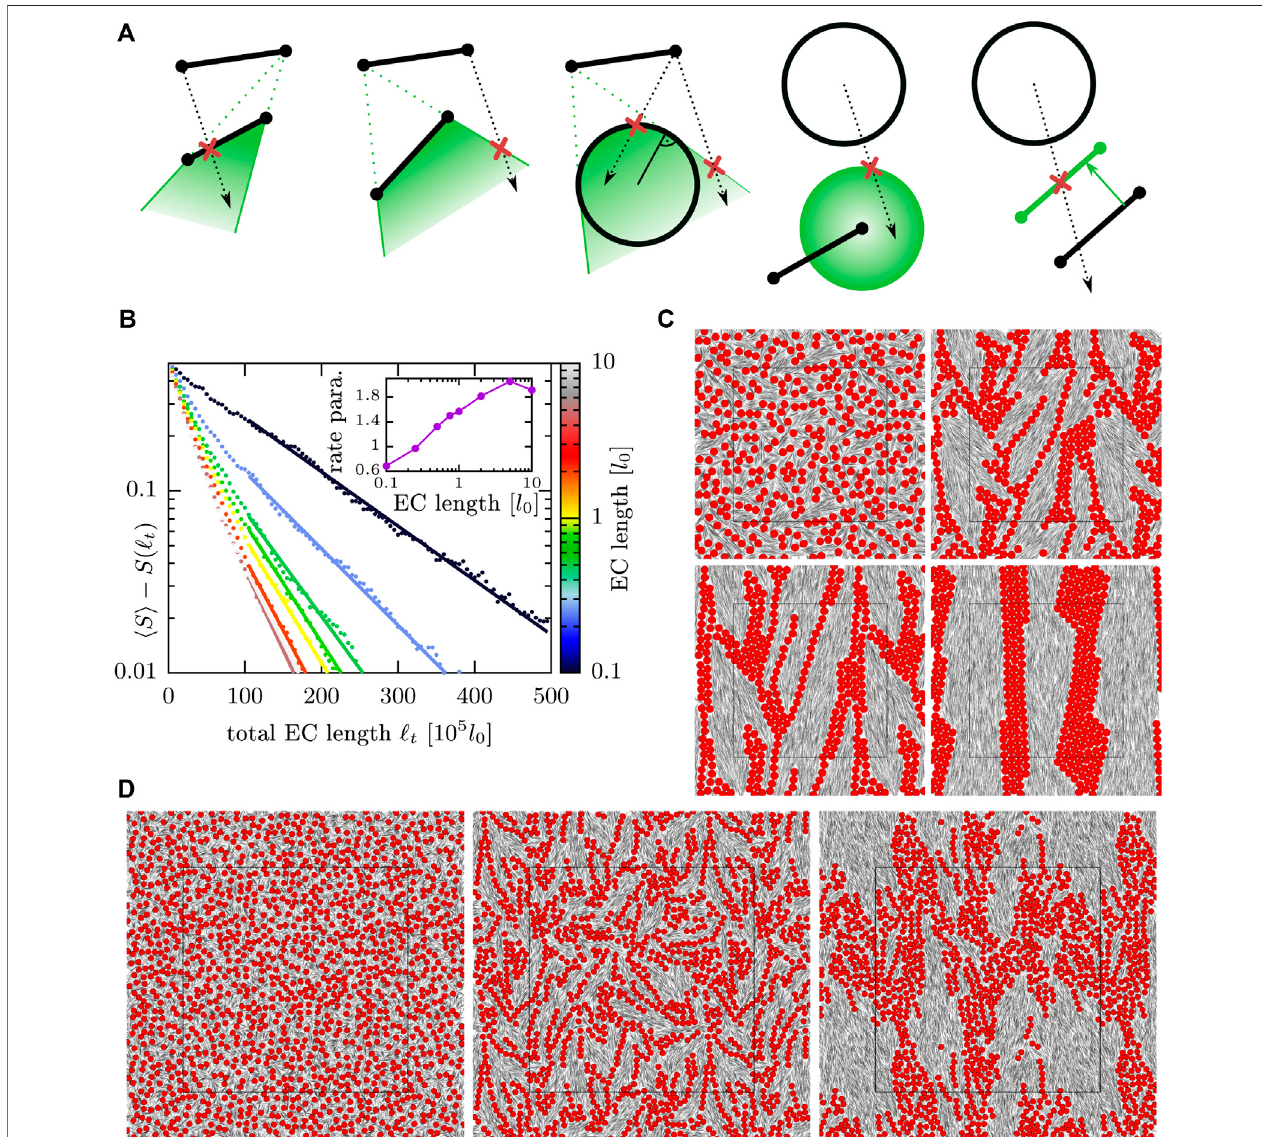
FIGURE9 |(A) List ofall geometrical cases where rejections/lifting between needles and disks occur ( fi rst two depict needle-needle, thethird needle-disk,and the lasttwoonessphere-needlecollisions).Ifaneedleisnothitatoneofitsendpoints( fi rstandlastpicture)conditionalliftingprobabilities λ ij forathree-particleinteractionare applied (B) Ef fi ciency gains with increasing EC length ℓ for a two-dimensional needle system in a volume of L × L at density ρ n (cid:2) 10 / l 2 0 . Starting at one random con fi gurationanensembleofsimulationswithdifferentEClengthsareconducted. Weshow thedifference betweenthenematic orderparameter over timeandthe equilibrium value yielding an exponential. The decay rate of the order parameter is used as ef fi ciency measure, where a simulation with ℓ (cid:2) 5 l 0 is 2.8 times more ef fi cient than a simulation with ℓ (cid:2) 0 . 1, where the latter took even 1.7 times the wall time, yielding a speed-up of ≈ 5 between ℓ (cid:2) 0 . 1 and ℓ (cid:2) 5 (cid:2) L / 2 (C and D) Evolution of a mixtureofhardneedlesoflength ł 0 (cid:2) 1andharddiskswithadiameter σ (cid:2) l 0 indicatinganeffectiveinteractionbetweendisks,whichfavorsparallelchaining (C) Asystem ofsize20